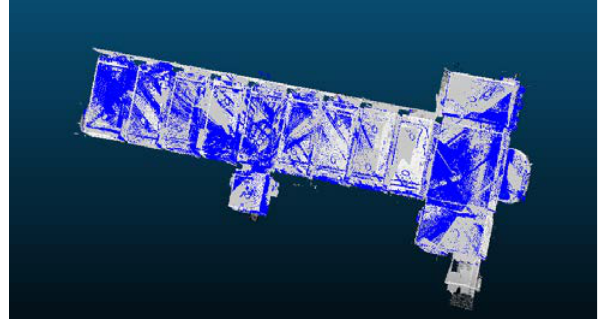
Figure 4: Registration of the Focus3D and i-MMS point clouds